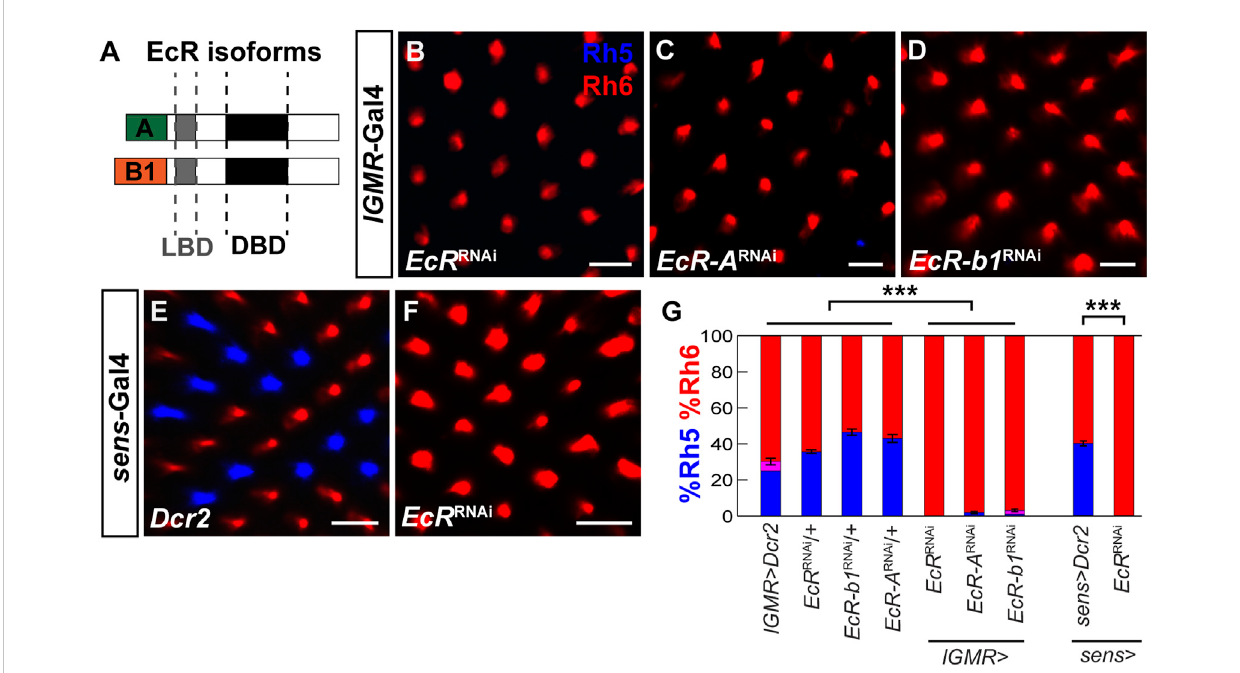
EcR is required cell autonomously to specify Rh5 fate. (A) Schematic of two EcR isoforms, EcR-A and EcR-b1, which contain identical DNA binding domains (DBD) and ligand binding domains (LBD) but differ in their N-terminal A/B domains. (B) Pan-photoreceptor knockdown of all EcR isoforms causes a loss of Rh5 and a gain of Rh6. (C, D) Pan-photoreceptor knockdown of the individual EcR isoforms EcR-A (C) and EcR-b1 (D) causes a loss of Rh5andgainofRh6. (E) Expressionof Dcr2 withtheR8driver sens-Gal4 at29 ° CdoesnotaffecttheRh5:Rh6ratio. (F) Expressionof EcR RNAi and Dcr2 with sens-Gal4 at29 ° CcausesalossofRh5andgainofRh6.Allscalebars,10 µm. (G) Quanti fi cationofR8subtypesincontrolsvs. EcR knockdowns.Mean %Rh6 was compared among genotypes with an ANOVA and a post hoc Tukey HSD Test; *** p < 0.0001. 5-8 retinas were scored for each